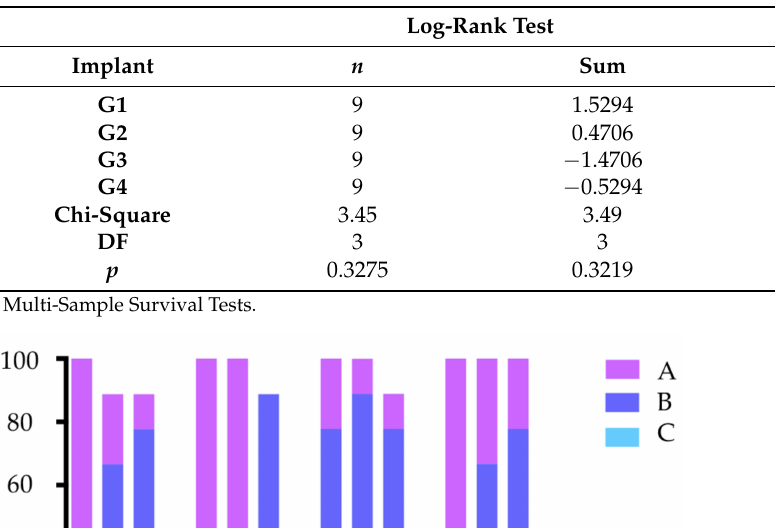
Table 3. Overall Comparisons 1 in time variable (cycles) according to the event variable (implant type).